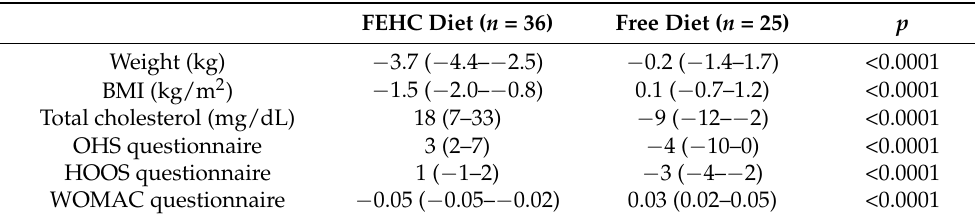
Table 2. Variation in anthropometric parameters and questionnaire scores from baseline (T0) to follow-up (T1) according to FEHC diet.